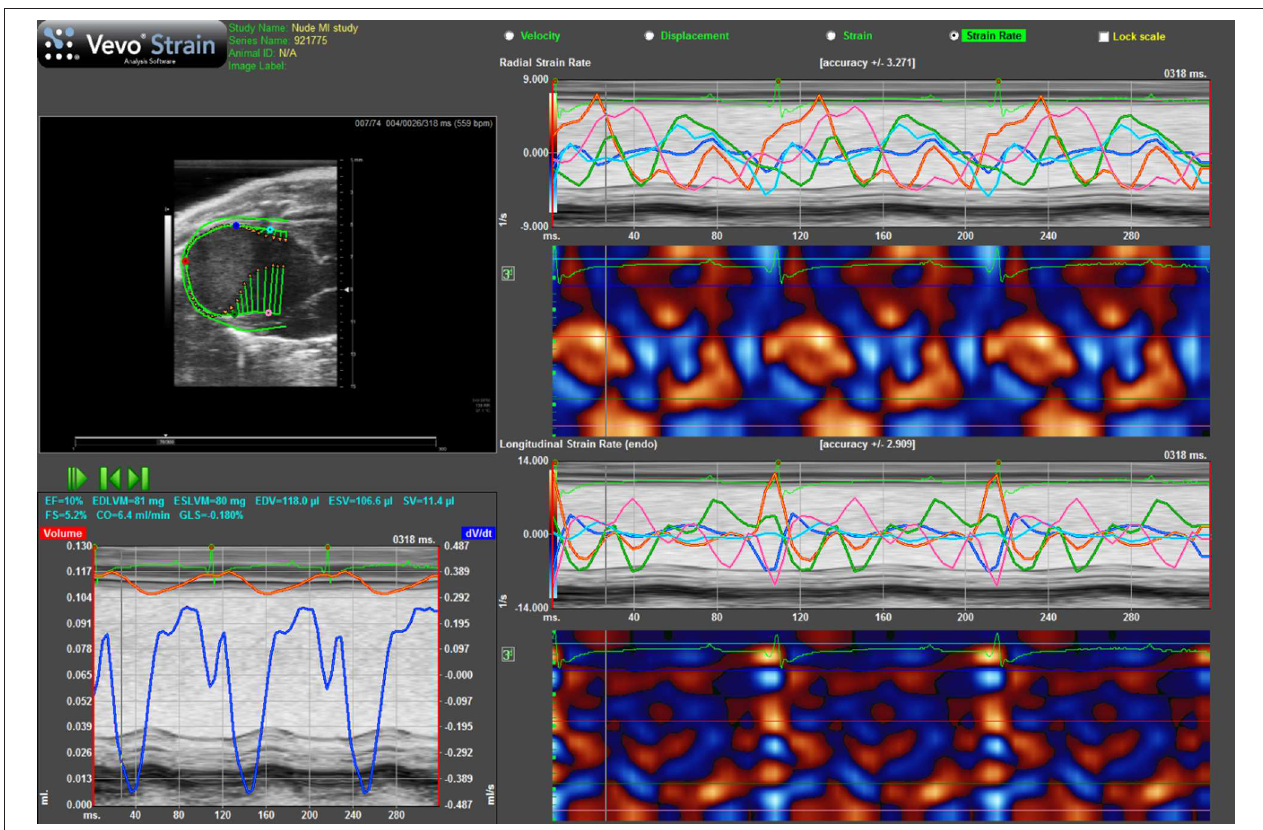
FIGURE 7 | Strain rate imaging of a nude mouse with MI as the result of ligation of left coronary artery. Top lhs is long-axis view of heart with arrows indicating direction and magnitude of movement of endocardial border. Bottom lhs shows change in volume of cavity over consecutive cardiac cycles alongside ECG and respiration. Top rhs shows radial strain-rate curves from five points selected on endocardial border while lower rhs shows longitudinal strain-rate curves from the same five